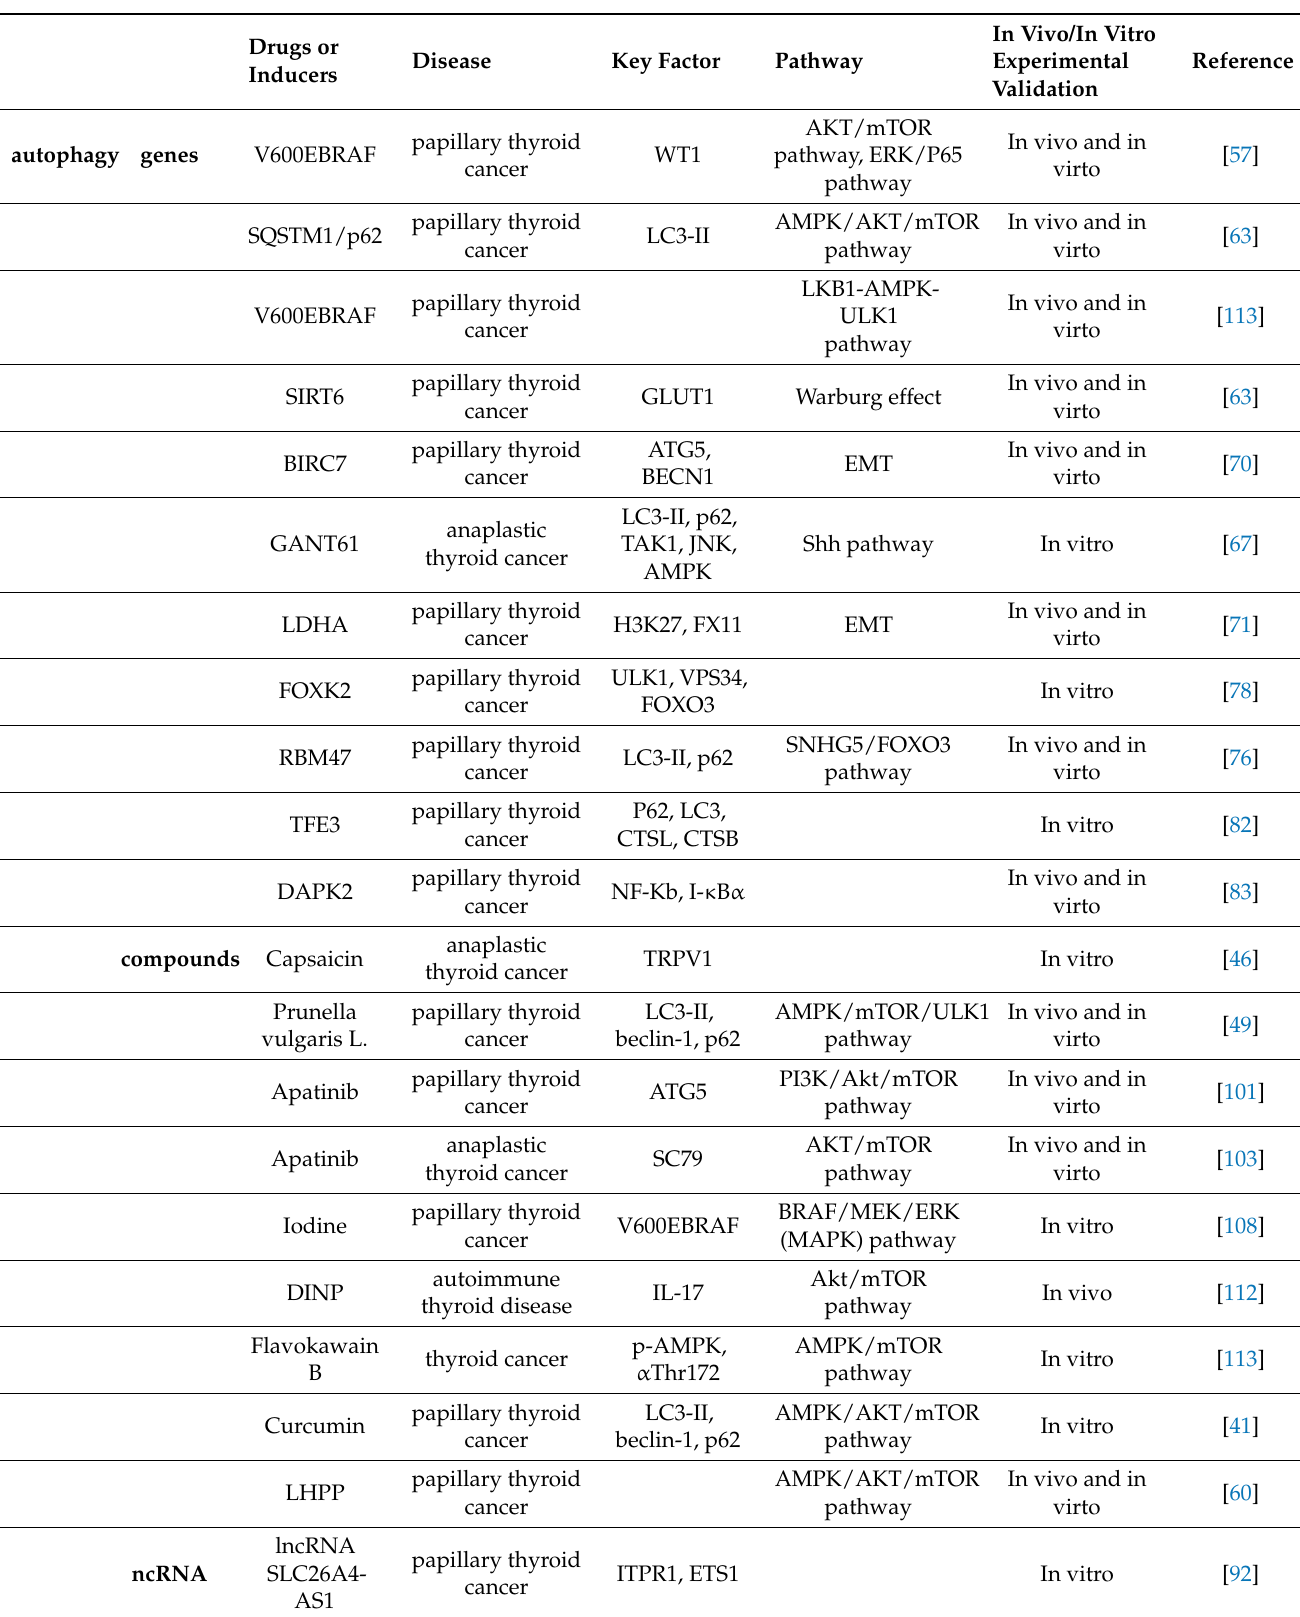
Table 1. The characteristic summary of NAPCD in thyroid